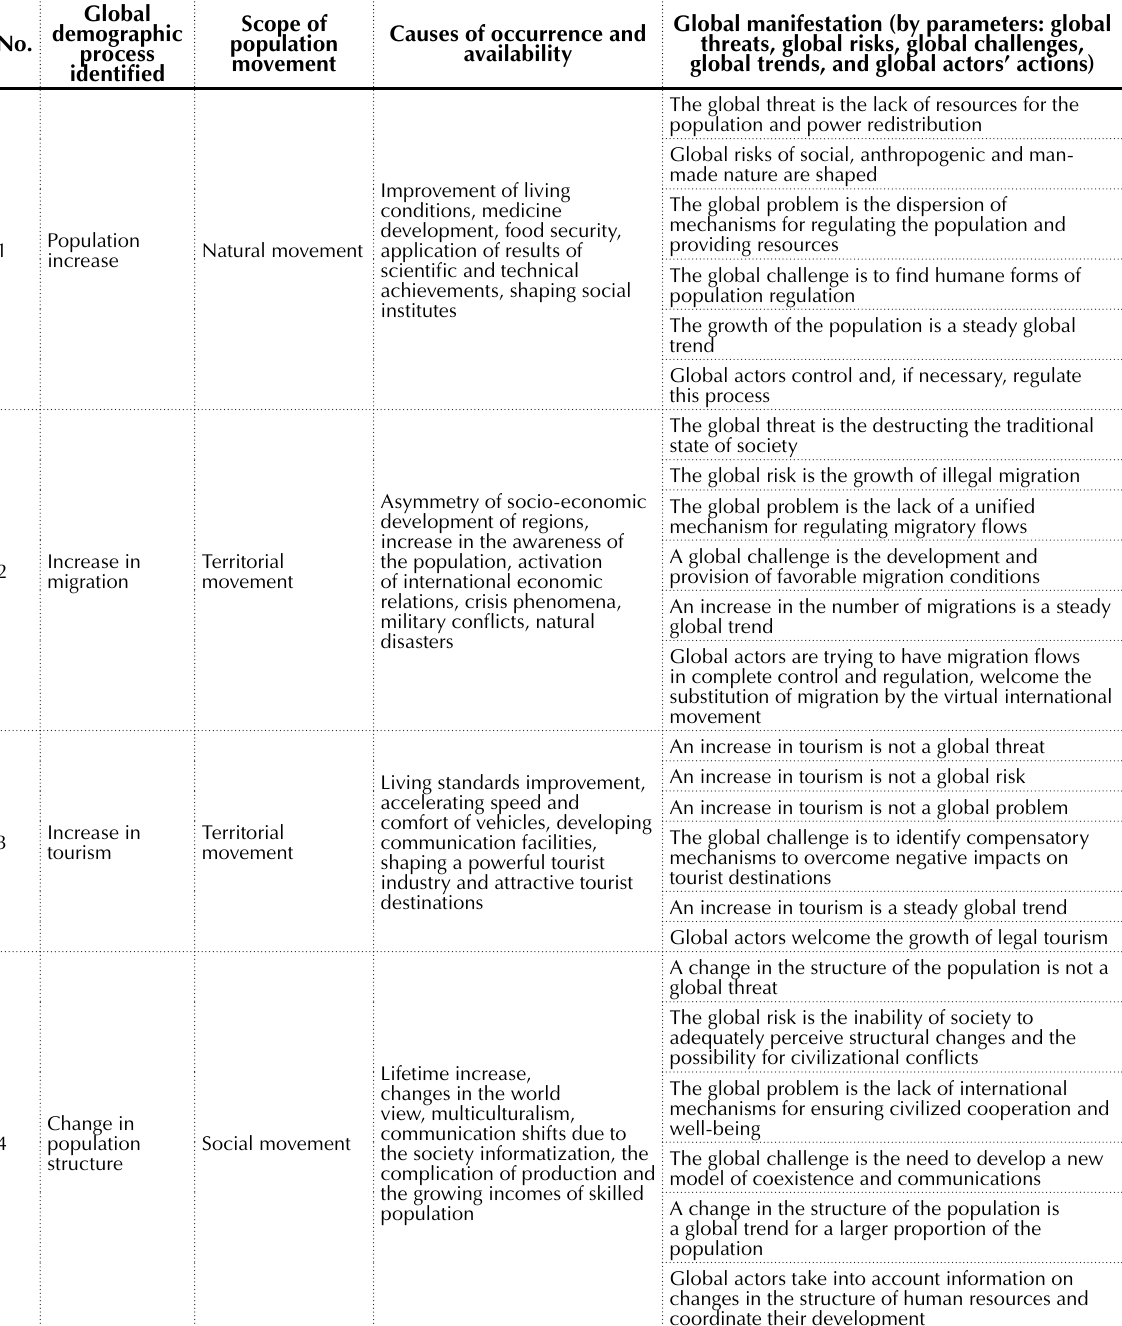
Table 1. Characteristics of current global demographic